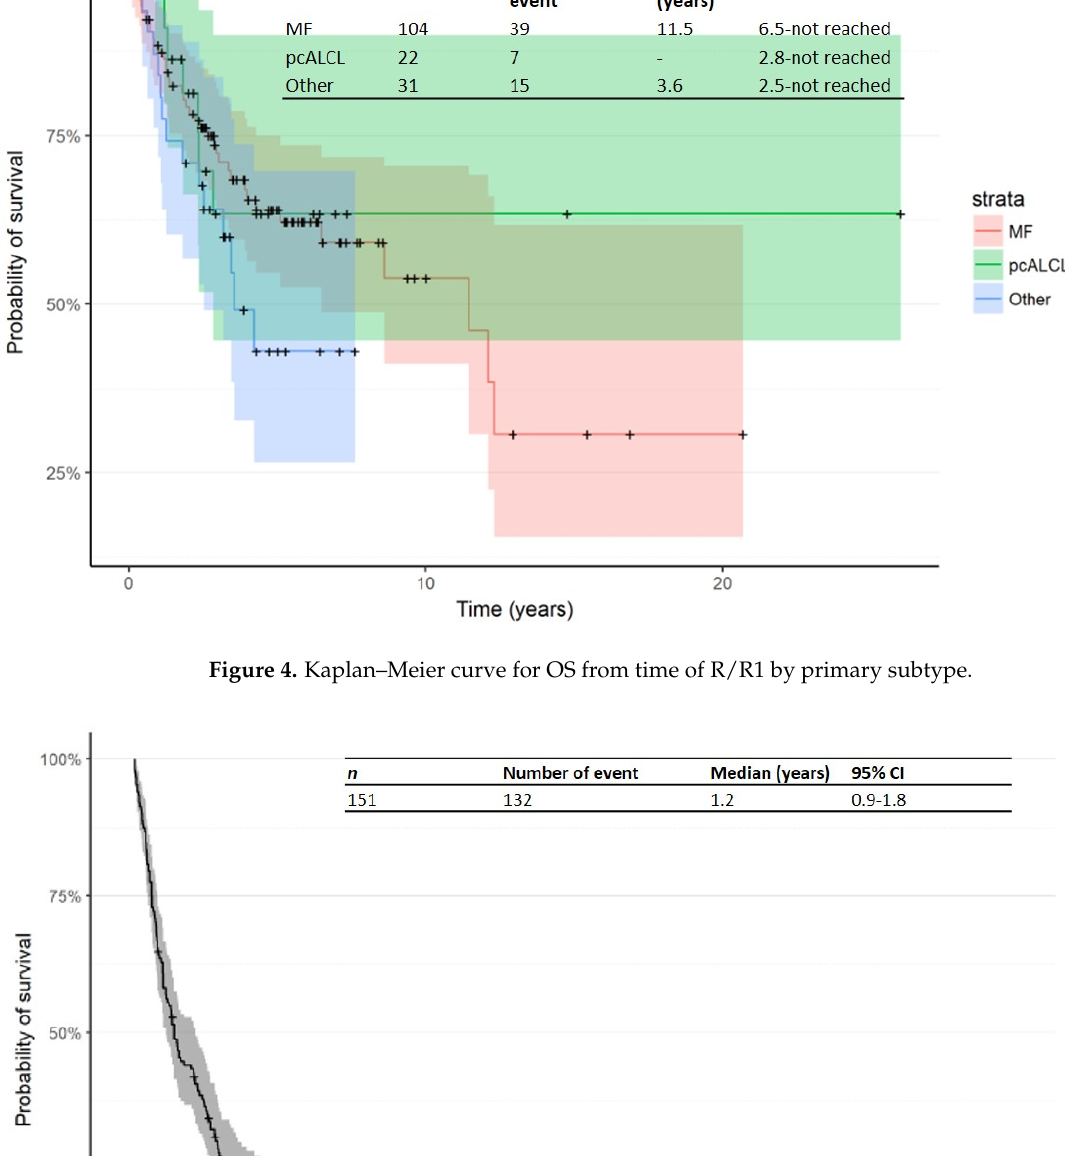
Figure 5. Kaplan–Meier curve for progression-free survival (PFS) from time of first R/R in patients receiving second-line therapy. Abbreviations: CI: confidence interval; PFS: progression-free survival; R/R: relapsed/refractory .